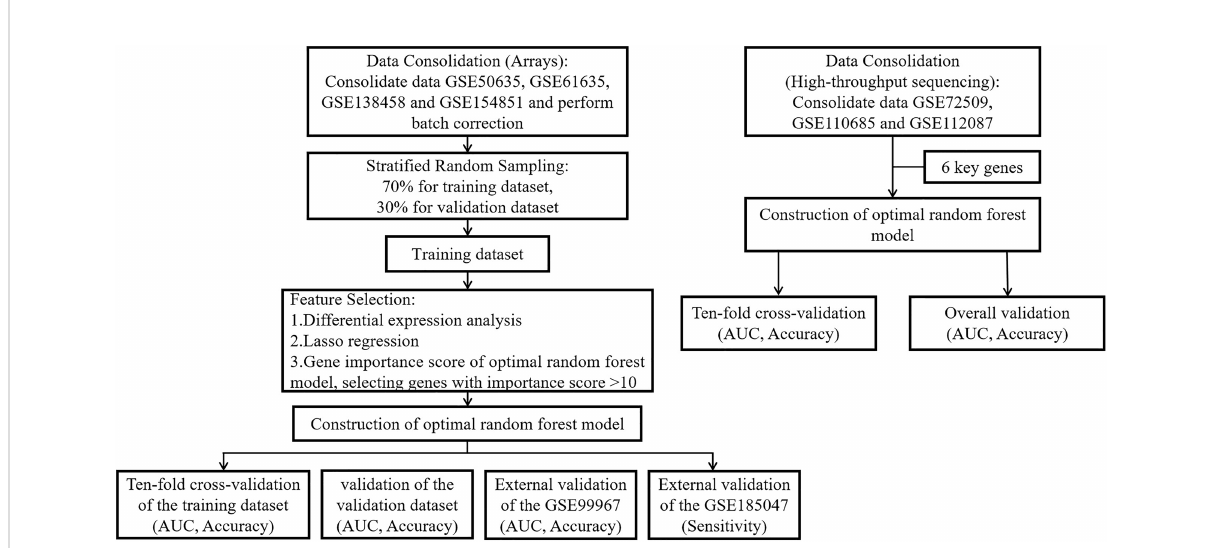
FIGURE 1 The fl ow chart of this study. Step 1: We merged the GSE50635, GSE61635, GSE138458 and GSE154851 datasets into a large dataset. Step 2: Strati fi ed random sampling methods were used by us for the partitioning of large data sets, and the ratio of the training dataset to the validation dataset was 7:3. Step 3: We performed differential expression analysis, Lasso regression, RF-RFE and feature importance score of RF in the training dataset to screen key genes. Step 4: A random forest prediction model was constructed through the inclusion of key genes. Step 5: We used 10-fold cross-validation to check the robustness of the training dataset and validated the model using the validation dataset and two external validation datasets to obtain the AUC, accuracy, and sensitivity. Step 6: In high-throughput sequencing (GSE72509, GSE110685 and GSE112087), we directly incorporated key genes using 10-fold cross-validation to demonstrate that the random forest prediction model is equally well robust in the context of high-throughput sequencing.